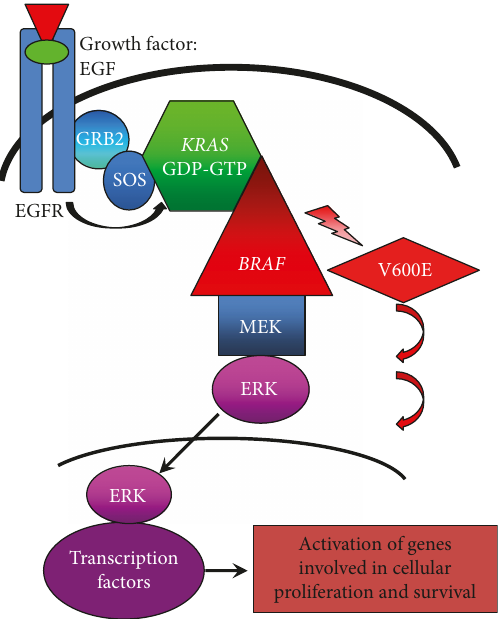
Figure 1: Diagram of the mitogen-activated protein kinase pathway. A signalling epidermal growth factor binds to the receptor (EGFR) on the cell surface causing its phosphorylation and activation. The activated signal is passed to sca ff olding proteins (GRB2 and SOS) which in turn promotes the removal of GDP from membrane-bound KRAS. KRAS then binds GTP, allowing its activation, and undergoes conformational change to bind and phosphorylate BRAF. The signalling cascade continues through MEK and ERK. Activated ERK translocates to the nucleus where it recruits transcription factors involved in cellular survival and growth. The V600E BRAF mutation allows for constitutive activation of BRAF and continuation of downstream signalling regardless of upstream